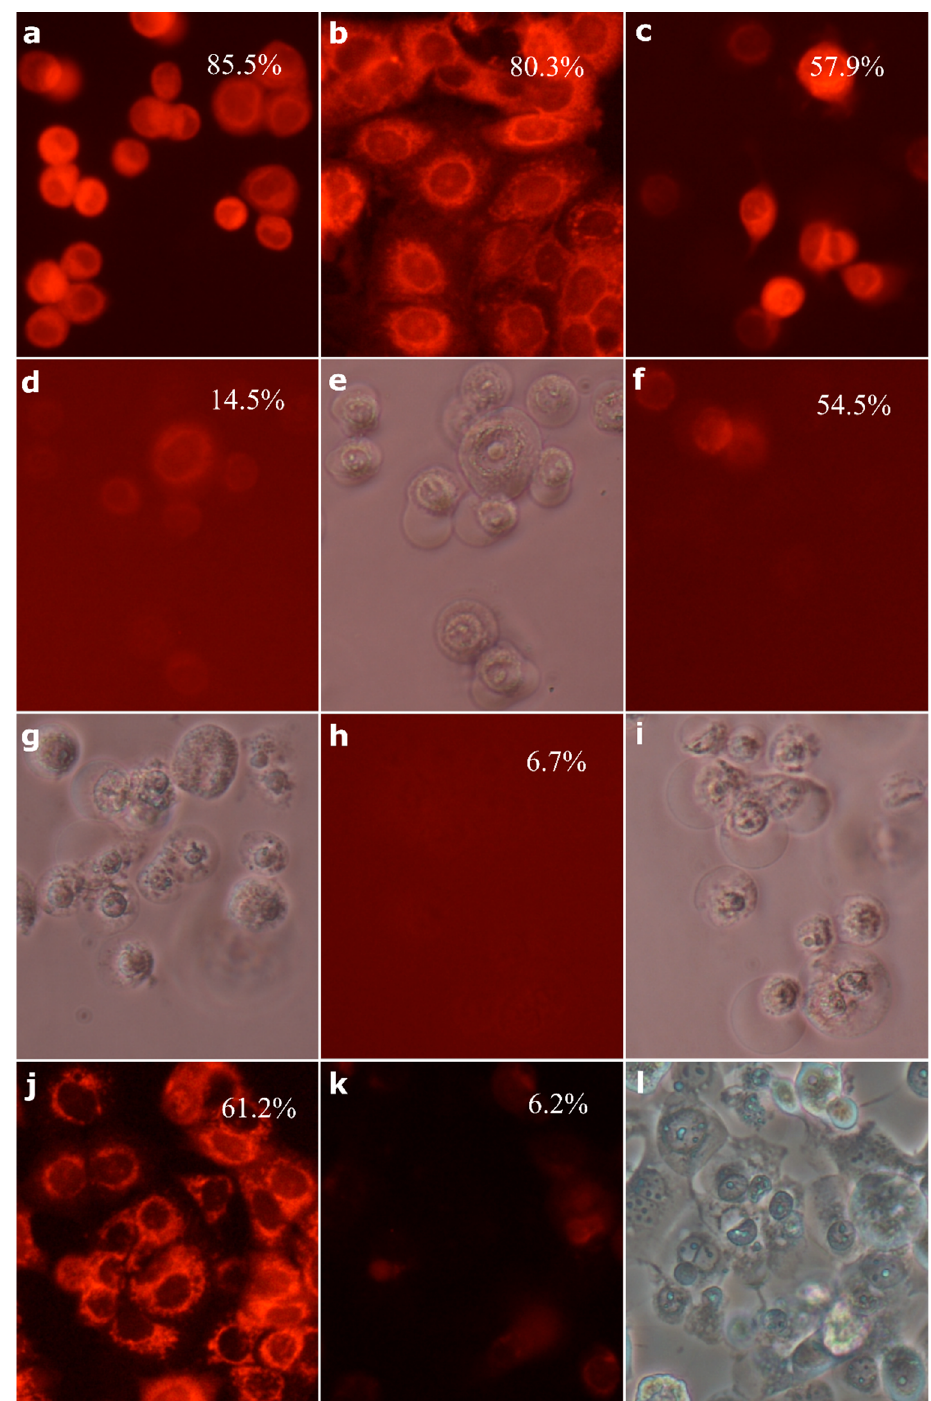
Figure 6. Effect of compound 4 on the mitochondrial membrane potential: control SK-BR-3 cells ( a ); control MCF-7 cells ( b ); SK-BR-3 cells treated with 10 µM compound 4 for 3 h ( c ); SK-BR-3 cells treated with 30 µM compound 4 for 3 h ( d ); SK-BR-3 cells treated with 10 µM compound 4 for 6 h ( f ); SK-BR-3 cells treated with 30 µM compound 4 for 6 h ( h ); MCF-7 cells treated with 10 µM compound 4 for 6 h ( j ); MCF-7 cells treated with 30 µM compound 4 for 6 h ( k ); numbers indicate percentage of TMRM positive cells determined by flow cytometry; phase-contrast photomicrograph of cells treated with compound 4 : SK-BR-3 cells treated with 30 µM compound 4 for 3 h ( e ); SK-BR-3 cells treated with 10 µM compound 4 for 6 h ( g ); SK-BR-3 cells treated with 30 µM compound 4 for 6 h ( i ); MCF-7 cells treated with 30 µM compound 4 for 6 h ( l ).